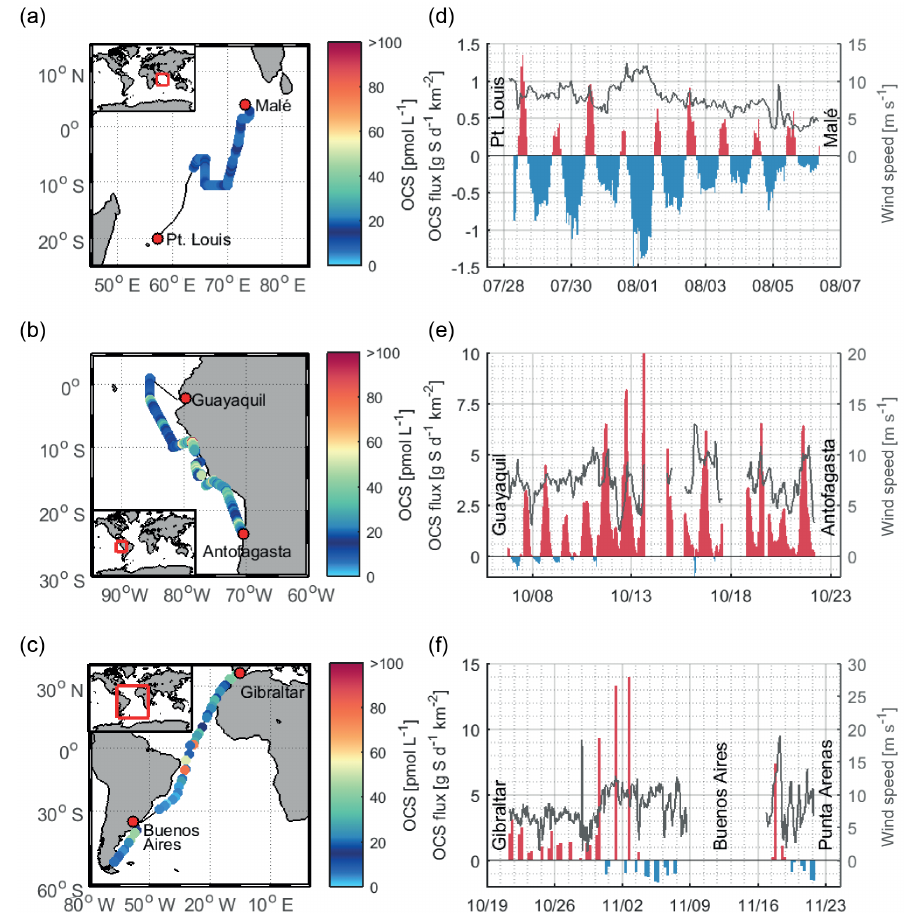
Figure 1. Observed OCS water concentrations and calculated emissions: observations of OCS concentrations in the surface ocean during the three cruises (a) OASIS, (b) ASTRA-OMZ, and (c) TransPEGASO as well as the corresponding emissions calculated based on the concentration gradient between water and marine boundary layer (d–f) . Outgassing is indicated in red bars; oceanic uptake in blue bars. The grey line shows wind speed measured onboard the vessels. Flux data are shown with different scales on the y axes. Data gaps occurred during stays in port and territorial waters or during instrument